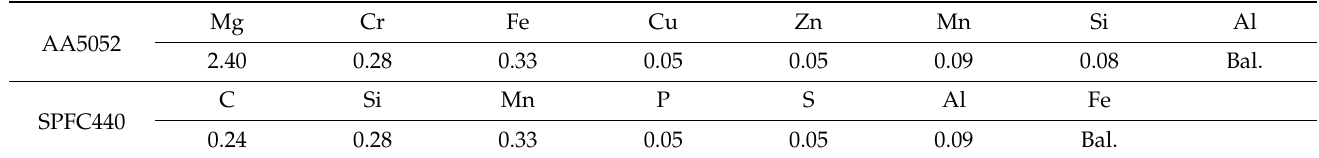
Table 1. Chemical composition of AA5052 alloy and SPFC 440 steel (wt.%).